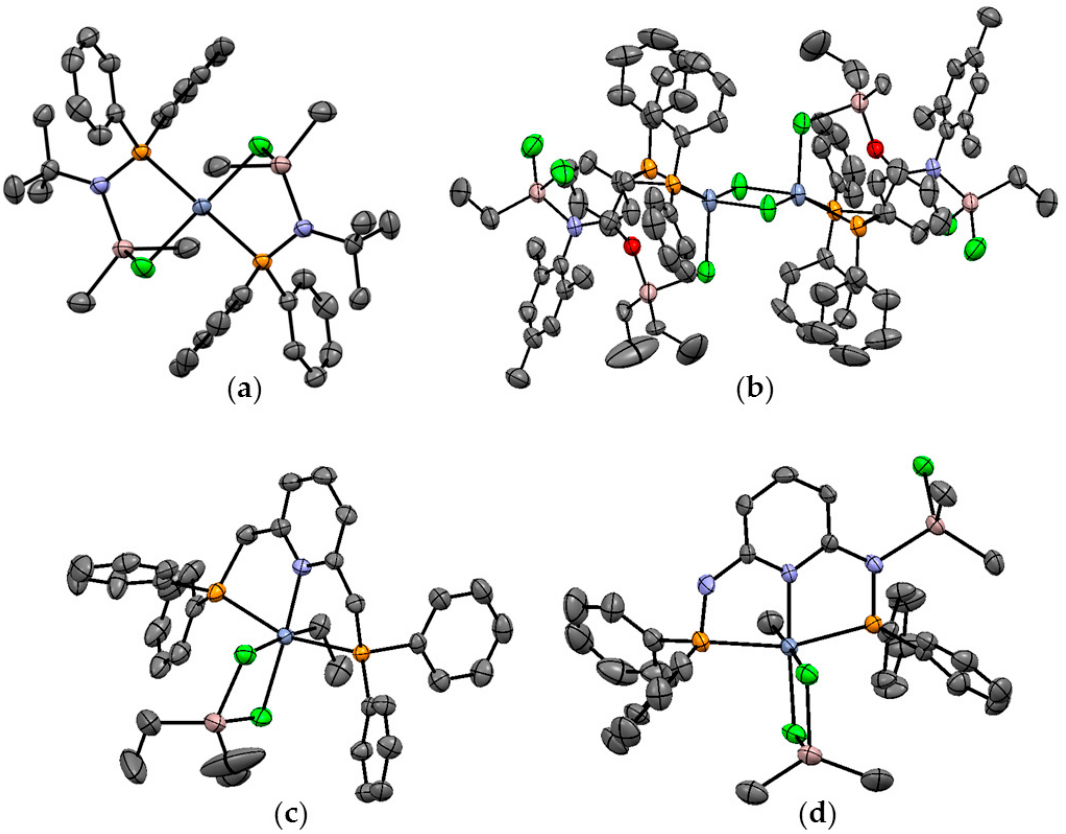
Figure 37. Examples of the molecular structures of the complexes containing Cr–( μ -Cl)–Al fragment (XRD analysis data), ( a ) Cr20 [255]; ( b ) Cr21 [256]; ( c ) Cr22 [257]; ( d ) Cr23 [257].